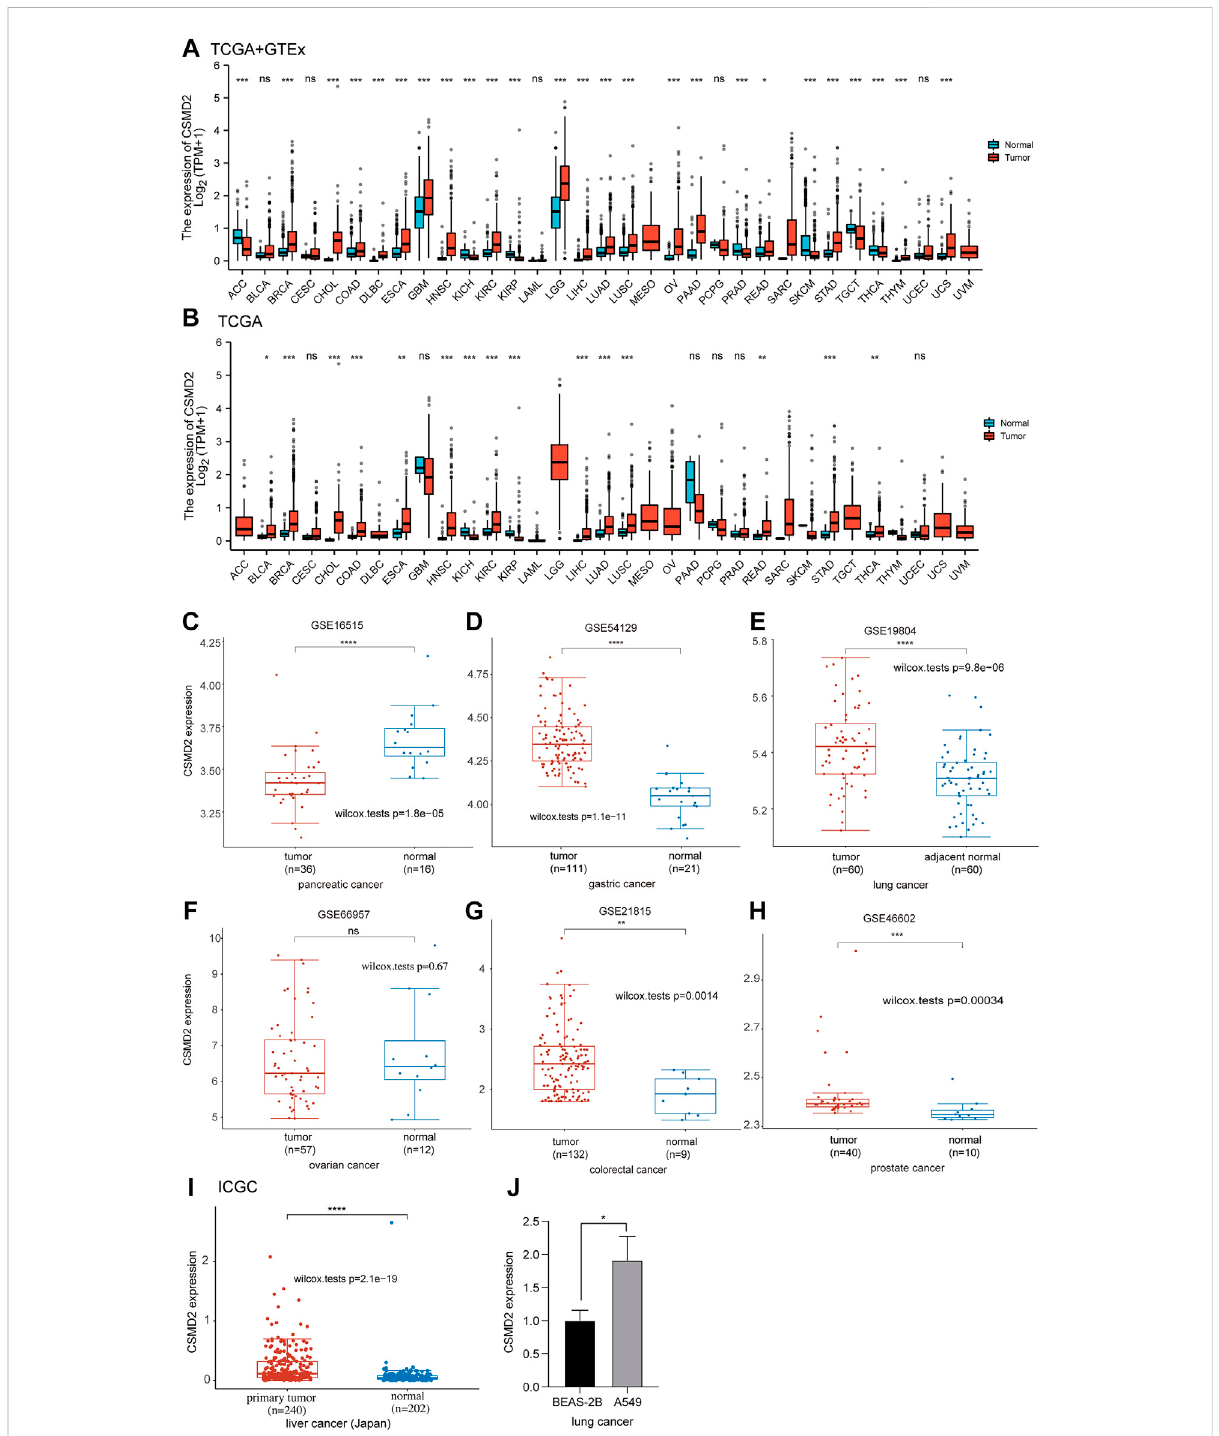
FIGURE 1 Differential mRNA expression of CSMD2. The boxplot shows CSMD2 expression in (A,B) 33 tumor types from TCGA and GTEx databases. The boxplot showsCSMD2 expressioninpancreatic cancer (C) ,gastric cancer (D) , lungcancer (E) ,ovarian cancer (F) ,colorectal cancer (G) ,andprostate cancer (H) from GEO database. (I) The boxplot shows CSMD2 expression in live cancer (Japan) from ICGC databse. (J) The expression of CSMD2 in the human lung bronchinal epithelial cell line BEAS-2B and human non-small cell lung cancer cell line A549 (ns, p ≥ 0.05; * p < 0.05; ** p < 0.01; *** p < 0.001; **** p <